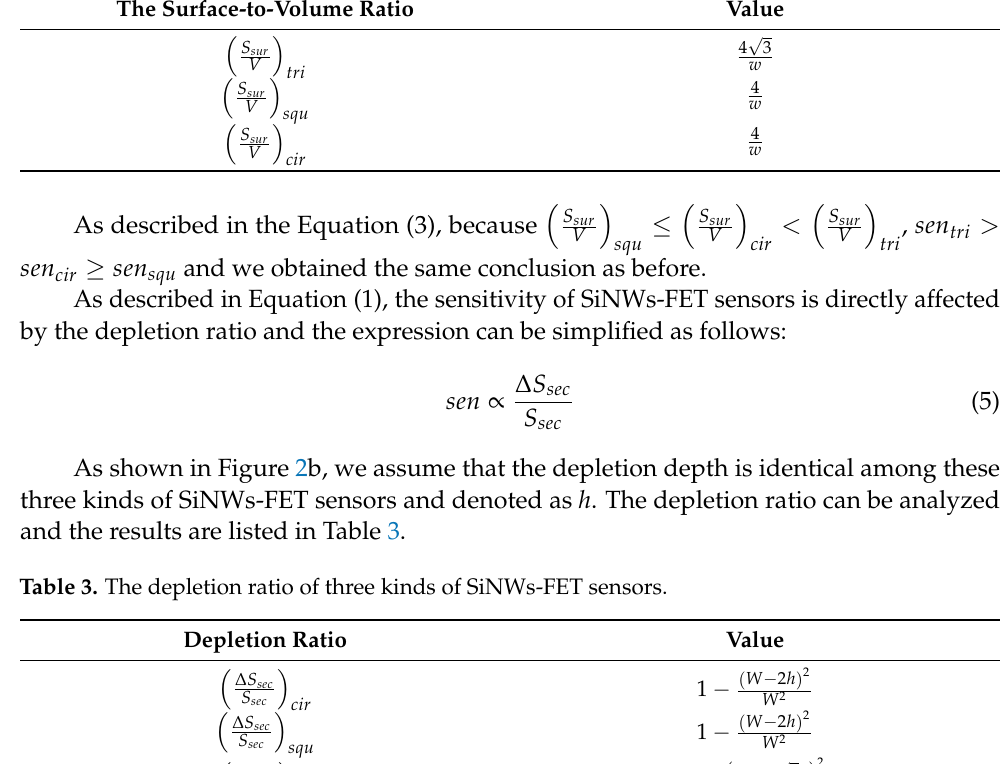
Table 2. The surface-to-volume ratio of three types of SiNWs-FET sensors. The Surface-to-Volume Ratio